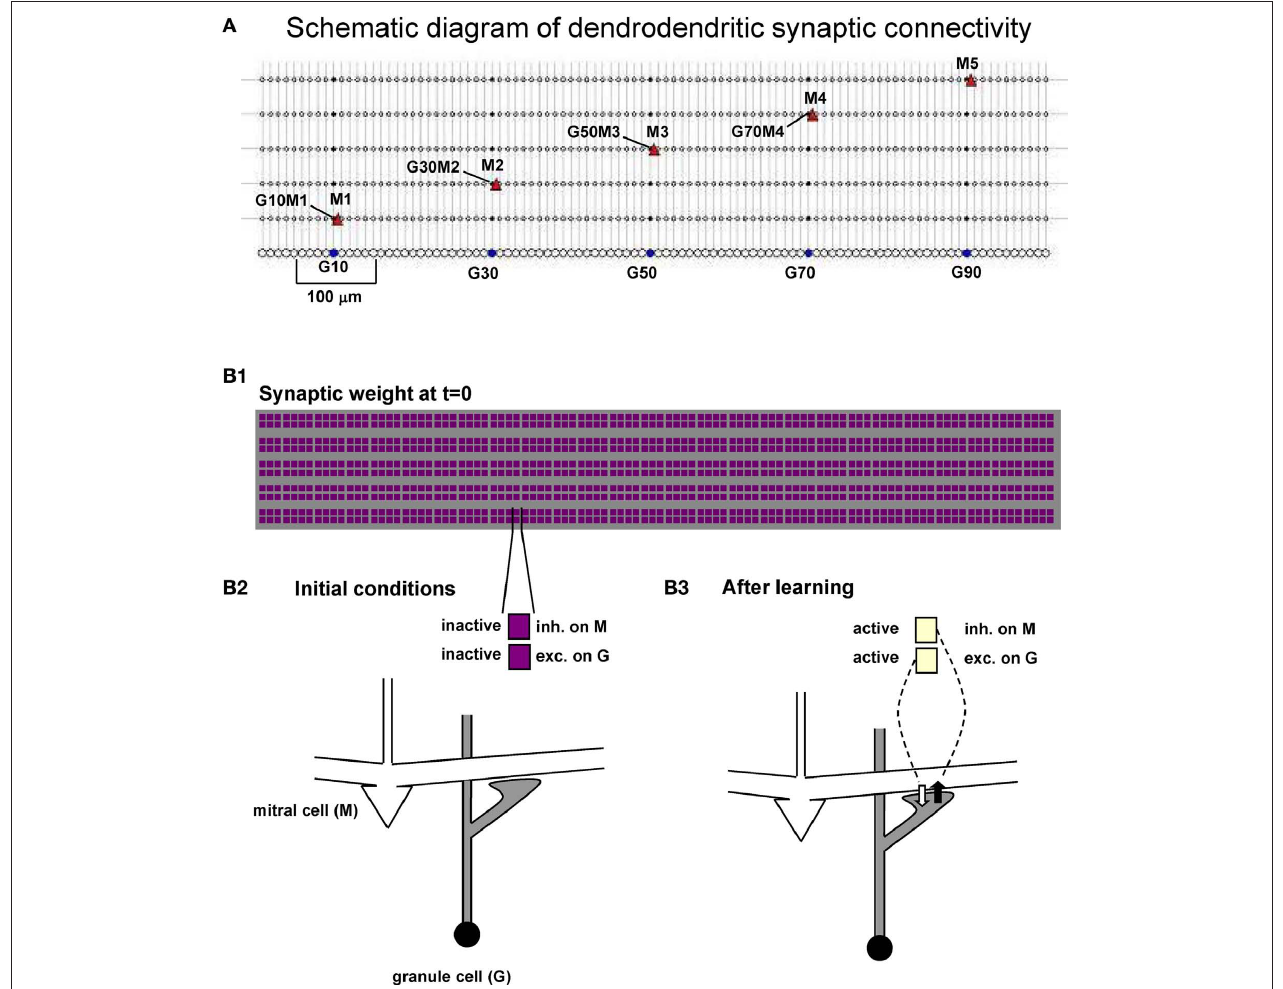
FIgure 2 | Dendrodendritic synapses form a network of mitral and granule cells. (A) Schematic diagram of the mitral and granule cell network used in all simulations; A few mitral cells and specific dendrodendritic synapses are indicated in the form G x M y , indicating a reciprocal synapse between Granule cell x and